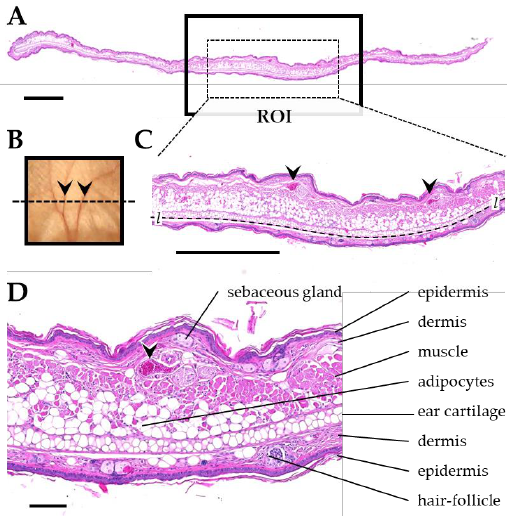
Figure 13. Anatomical landmarks used for definition of the ROI in transversal ear sections. ( A ) Histological section of the pinna. The radiated region of the pinna is indicated by a black box. The dotted line in ( B ) indicates the orientation of the section through the radiated area of the pinna. ( C ) ROI sampled for histological analysis and morphometric analysis (dotted rectangle in A ). The ROI contains at least two section profiles of ear veins (arrowheads) and skeletal musculature. The dotted line marks the interface of the ear cartilage, used to measure the length l of the ROI (i.e., the section width). ( D ) Detail enlargement of the image shown in C , demonstrating relevant histological structures. Formalin-fixed para ffi n embedded sections, H&E staining. Scale bar = 1 mm in A and C , and 100 µ m in D